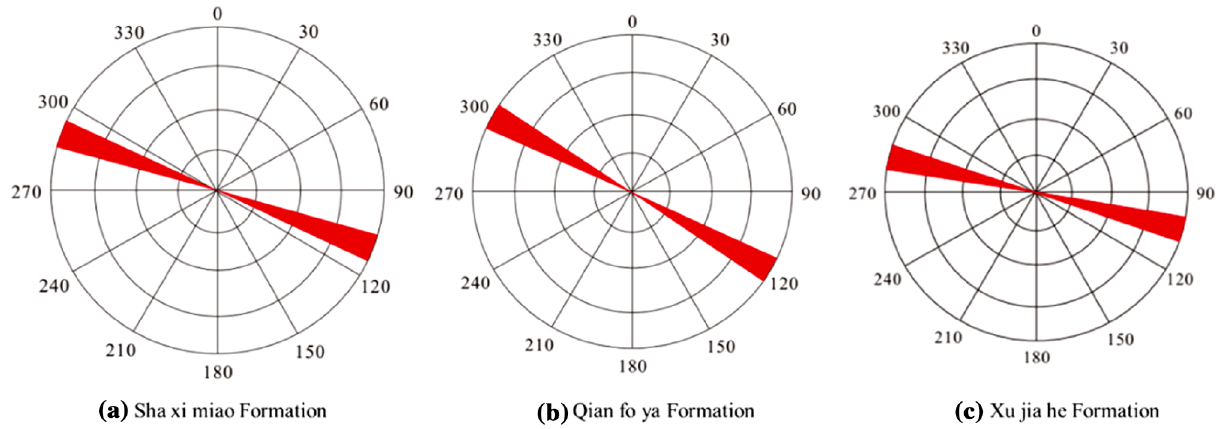
Fig. 12 In situ stress azimuth of terrigenous clastic rock formation